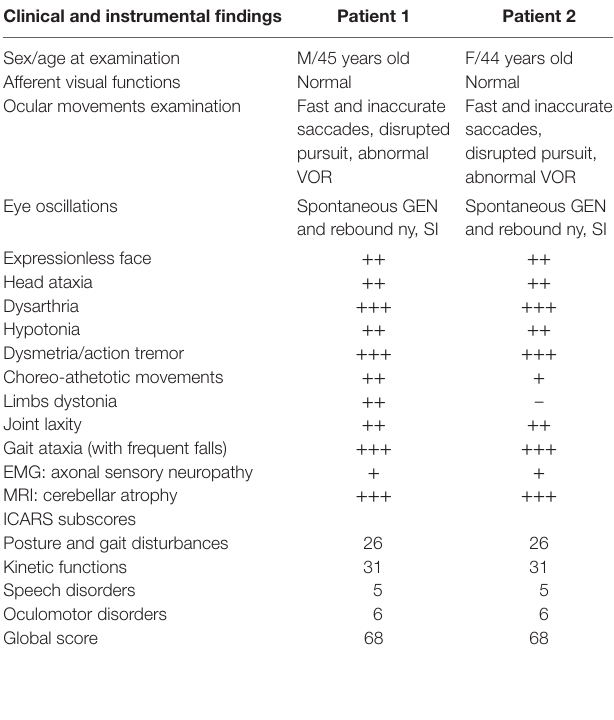
TaBle 1 | Demographics, clinical, and instrumental findings of patients with ataxia-telangiectasia-like disorder.